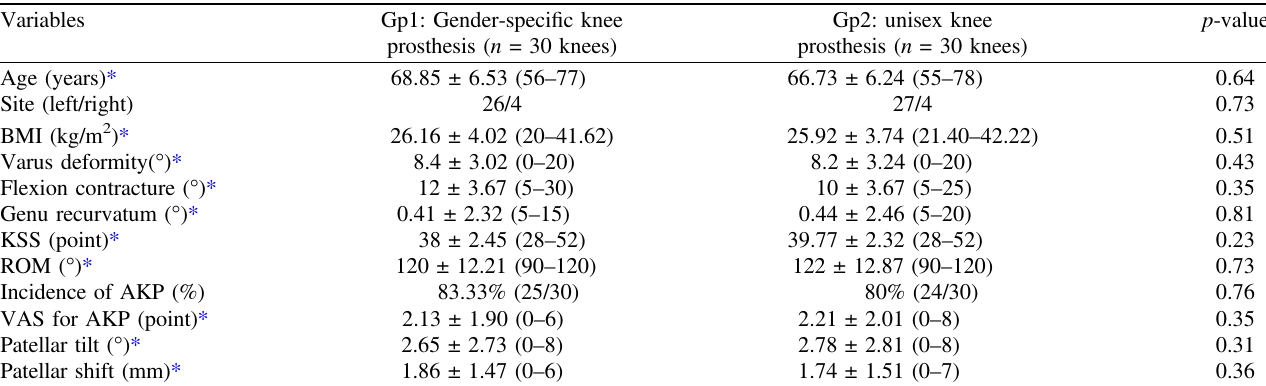
Table 1. Baseline patient